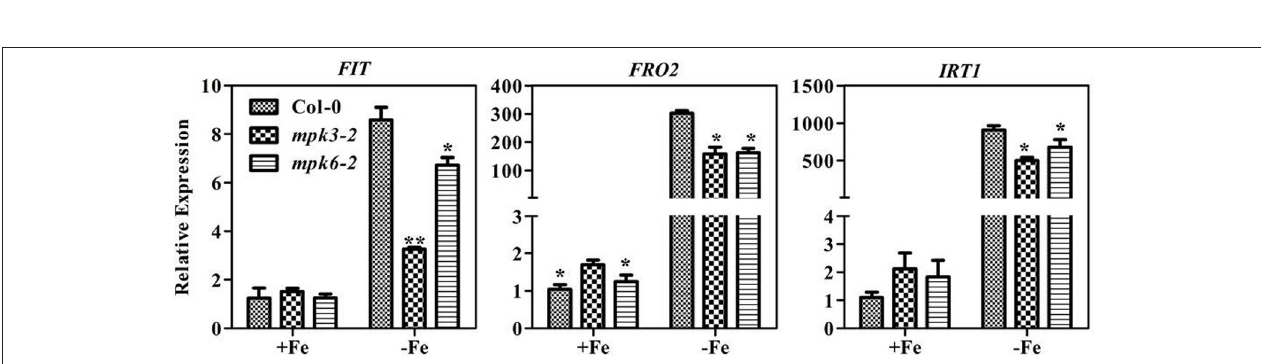
FIGURE 8 | Transcription levels of Fe-deficiency responsive genes in mpk3 and mpk6 mutants. Ten day old seedlings cultured in swimming medium were transferred to Fe-deficient medium for 7 days and sampled for RNA extraction. All values are expressed relative to the expression level under Fe-sufficient conditions (control—set to 1.0) as appropriate. Data are shown as the mean ± SEM ( n = 3 ). Columns marked with “ * ” indicate a significant difference ( P < 0.05 ), and “ ** ” indicate a highly significantly difference ( P < 0.01 ).